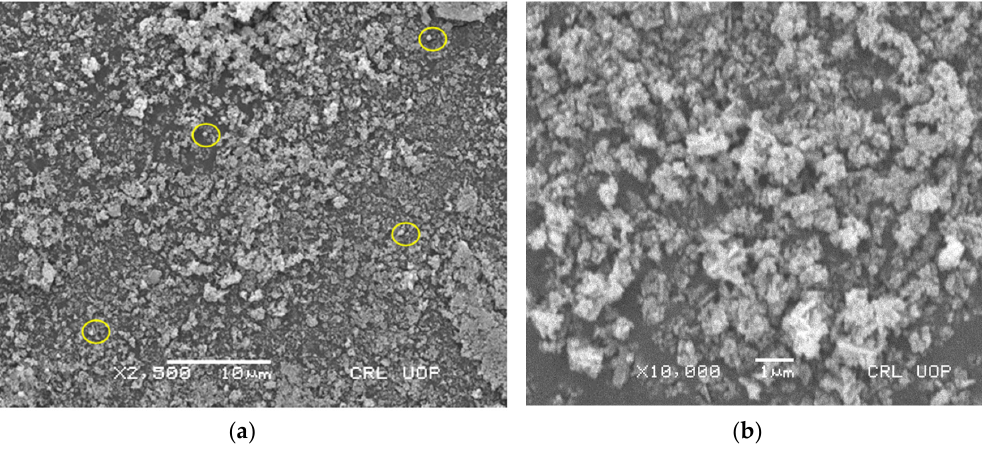
Figure 5. SEM analysis of the synthesized SNPs at different resolutions. ( a ) polydispersed. ( b ) coag- ulated.